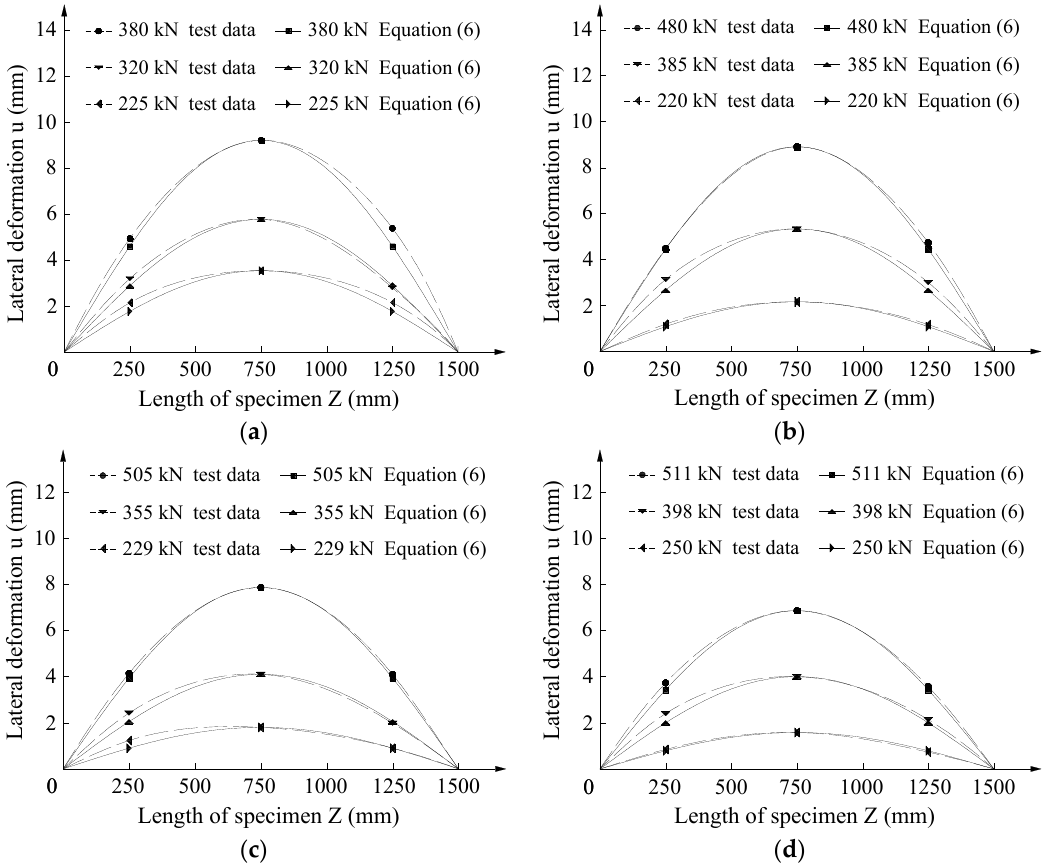
Figure 11. Lateral deformation of: ( a ) S-0; ( b ) S-1; ( c ) S-2; ( d ) S-3.